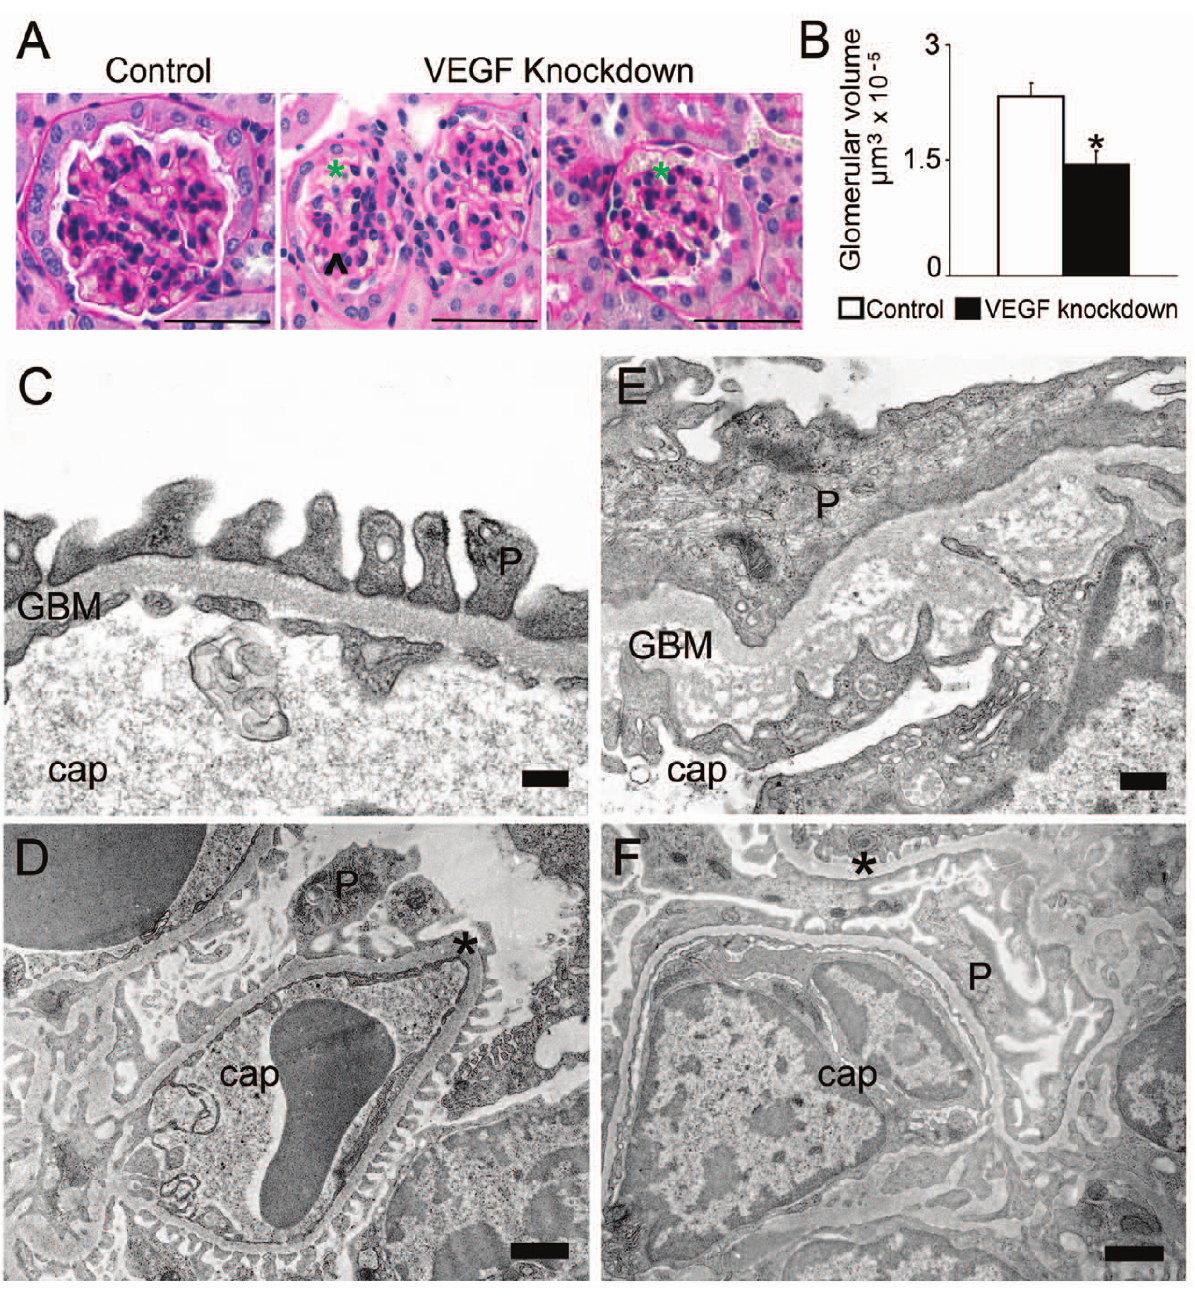
Figure 3. VEGF knockdown glomerular phenotype. (A) PAS stain shows mesangiolysis (arrowhead), microaneurisms (green asterisk) and decreased glomerular volume in VEGF-A knockdown glomeruli, scale bars =50 m m. (B) Quantitation of glomerular volume reveals that VEGF knockdown induces significant decrease in glomerular size. * indicates P , 0.05 vs. control. (C-D) TEM: control glomeruli show normal ultrastructure; scale bars =200 nm (C) and 1 m m (D). (E-F) TEM: VEGF knockdown glomeruli show endothelial cell swelling, vacuolization and decreased fenestration; GBM lamination of the lamina densa, irregular thickening and interdigitations of the endothelium; podocyte foot process effacement; scale bars=500 9 nm (E) and 1 m m (F). Cap=capillary, P=podocyte, * =GBM.